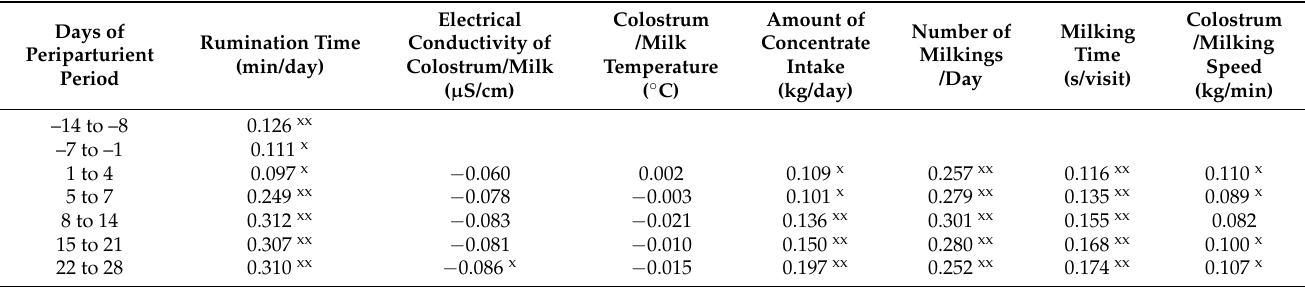
Table 4. Pearson correlation coefficients between rumination time, milking parameter and milk traits in in different periparturient periods and lactational milk